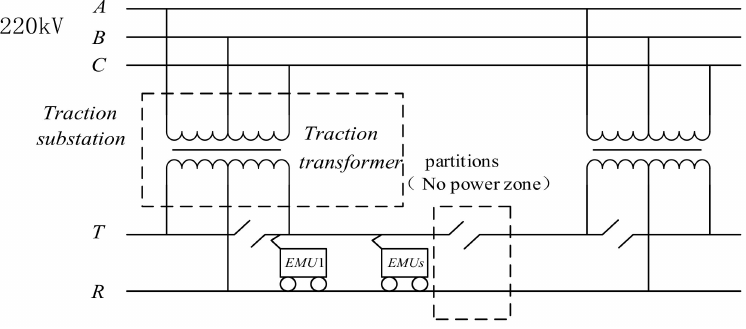
Figure 1. Supply